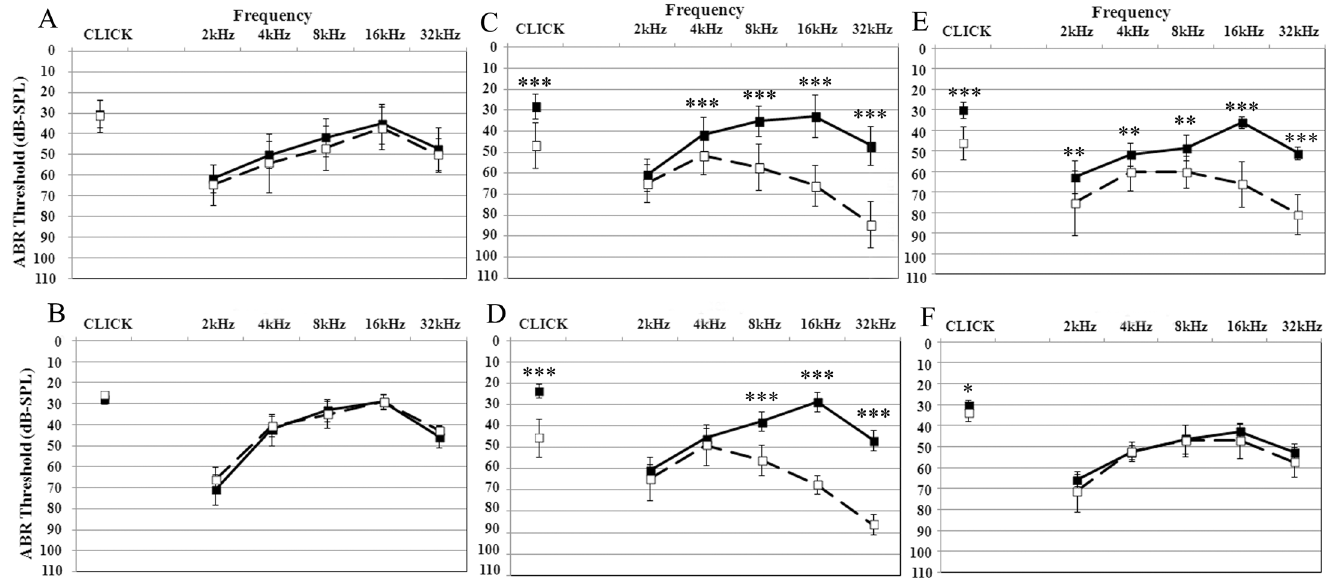
Fig 1. ABR threshold averages for each frequency measured before (continuous line) and 96 h after (dashed line) cisplatin treatment. The letters A-F indicate the treatment group described in the Materials and Methods section. ABR thresholds are expressed in dB SPL ± standard deviation. ** : t test p-value < 0.01; *** : t test p-value <